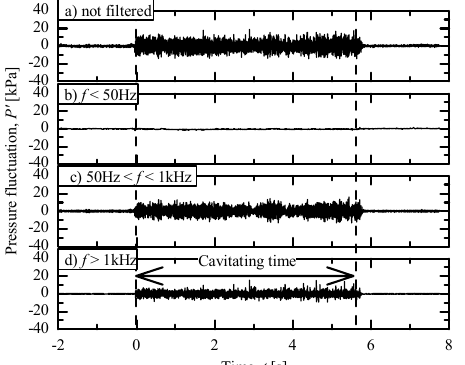
Fig. 9 Time evolution of the pressure fluctuation downstream of the nozzle in the intermediate cavitation type: a) not filtered, b) low pass filtered, c) band pass filtered, and d) high pass